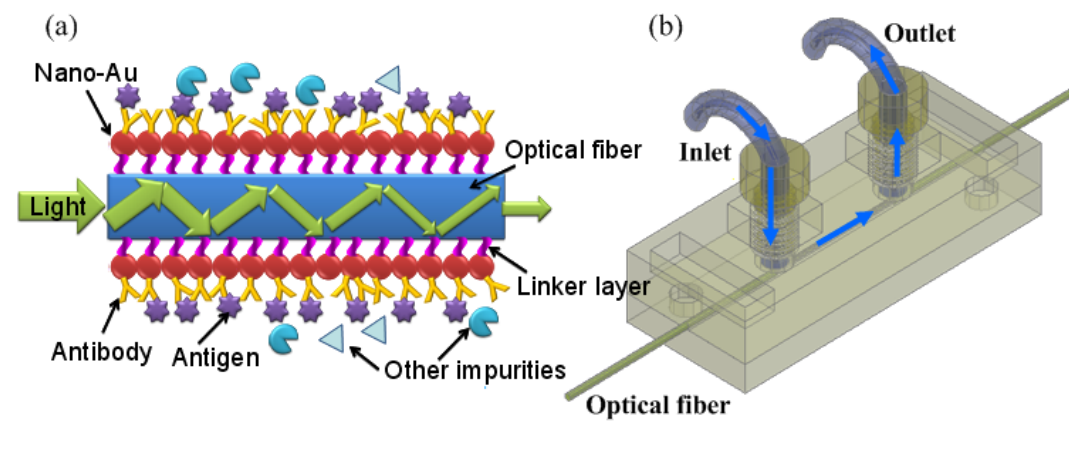
Figure 1. Schematic illustration of the FO-LPR microfluidic chip: (a) detecting principle of the FO-LPR and (b) structure of the chip and illustration of fluidic